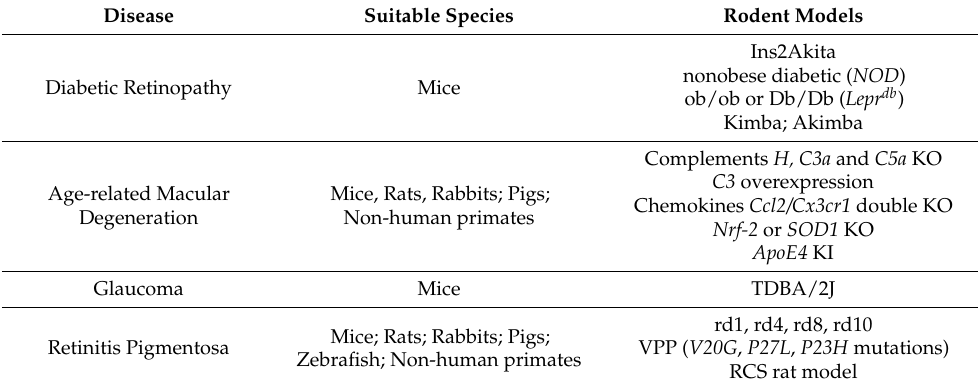
Table 1. Most-used rodent models of retinal dystrophy. KO: knock-out; KI: knock-in; RCS: the Royal College of Surgeons. Disease Suitable Species Rodent Models Diabetic Retinopathy Mice Age-related Macular Mice, Rats, Rabbits; Pigs; Degeneration Non-human primates